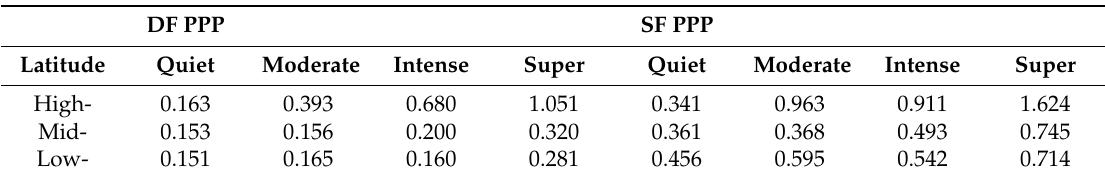
Table 3. The 3D RMS statistics of GPS DF and SF PPP for all stations in high-, mid-, and low-latitudes during the quiet, moderate, intense, and super storms period (Unit: m).